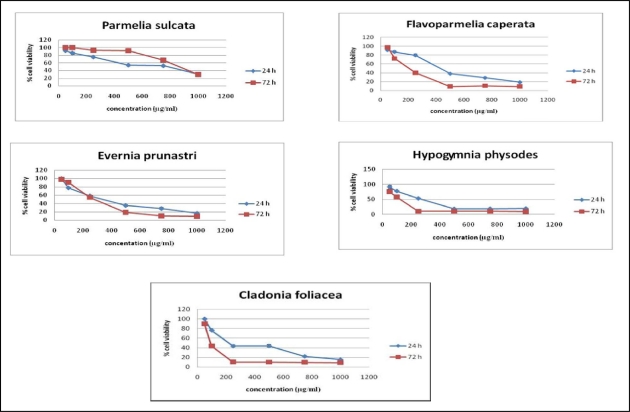
The dose-response effect of lichen extracts on HCT-116 cells growth. The cells were treated with methanol extract in concentration range from 50–1000 μg/mL. The antiproliferative effects were measured by MTT assay after 24 and 72 h exposure. Results were expressed as the means ± SE from three independent experiments.